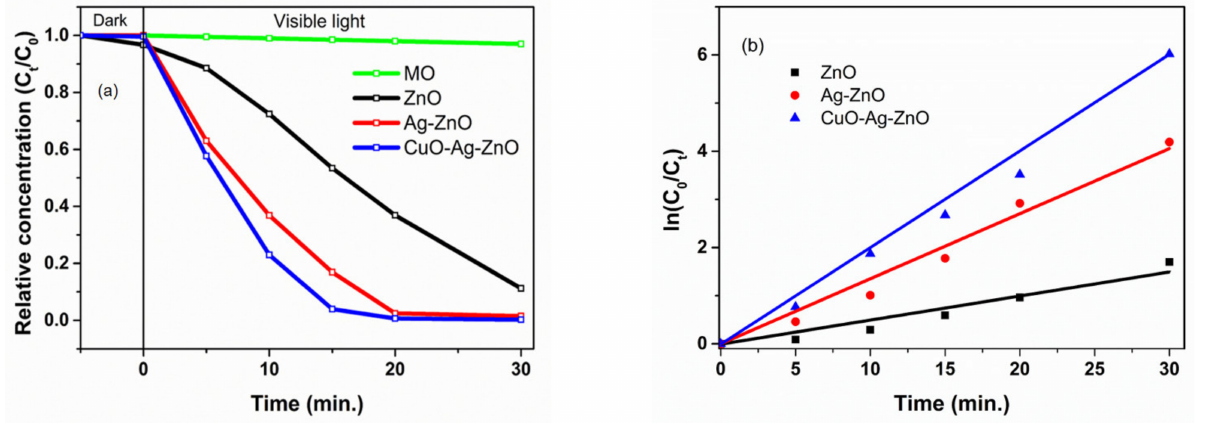
Figure 10. ( a ) Kinetics of MO photodegradation by the prepared samples, and ( b ) In(C/Co) curve as a function of time for the photodegradation process of